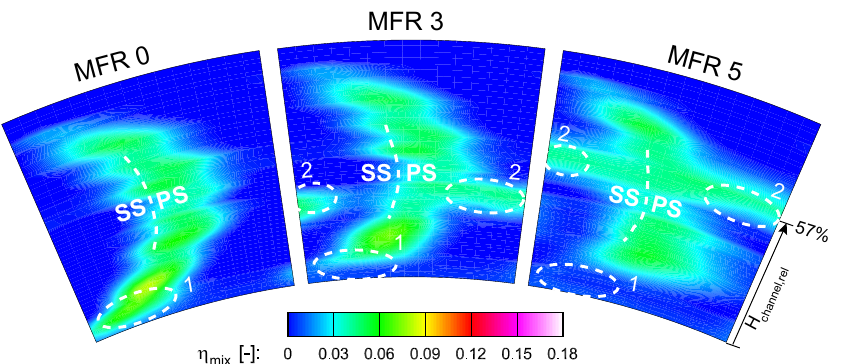
Figure 5. Flow tracing, varied MFR, trailing edge (TE) seeding.